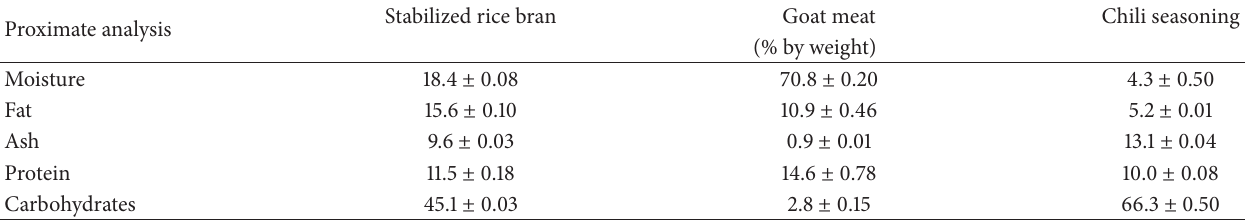
Table 1: Proximate composition of stabilized rice bran, goat meat, and chili seasoning (Means ± s.e.).